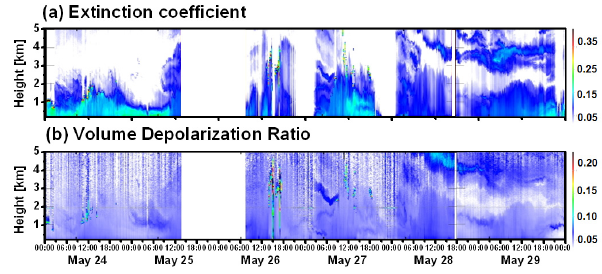
Fig. 1. Time-altitude plot of the extinction coefficient (a) and the de- polarization ratio (b) at 532nm, measured from 00:00LT on 4 May to 24:00LT on 9 May 2009.